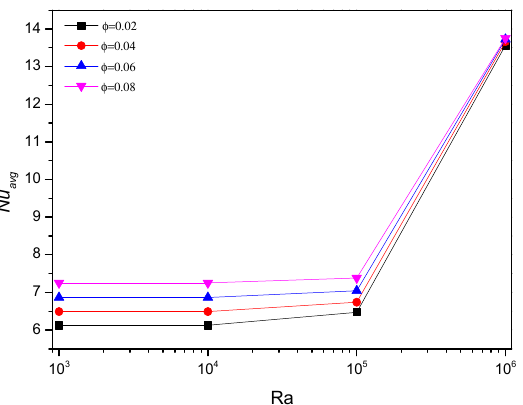
Figure 7. Average Nusselt number (Nu ave ) as a function of Rayleigh number (Ra) at various values of solid volume fraction ( φ ). Ha = 0, Da = 0.01 and ε p = 0.4.